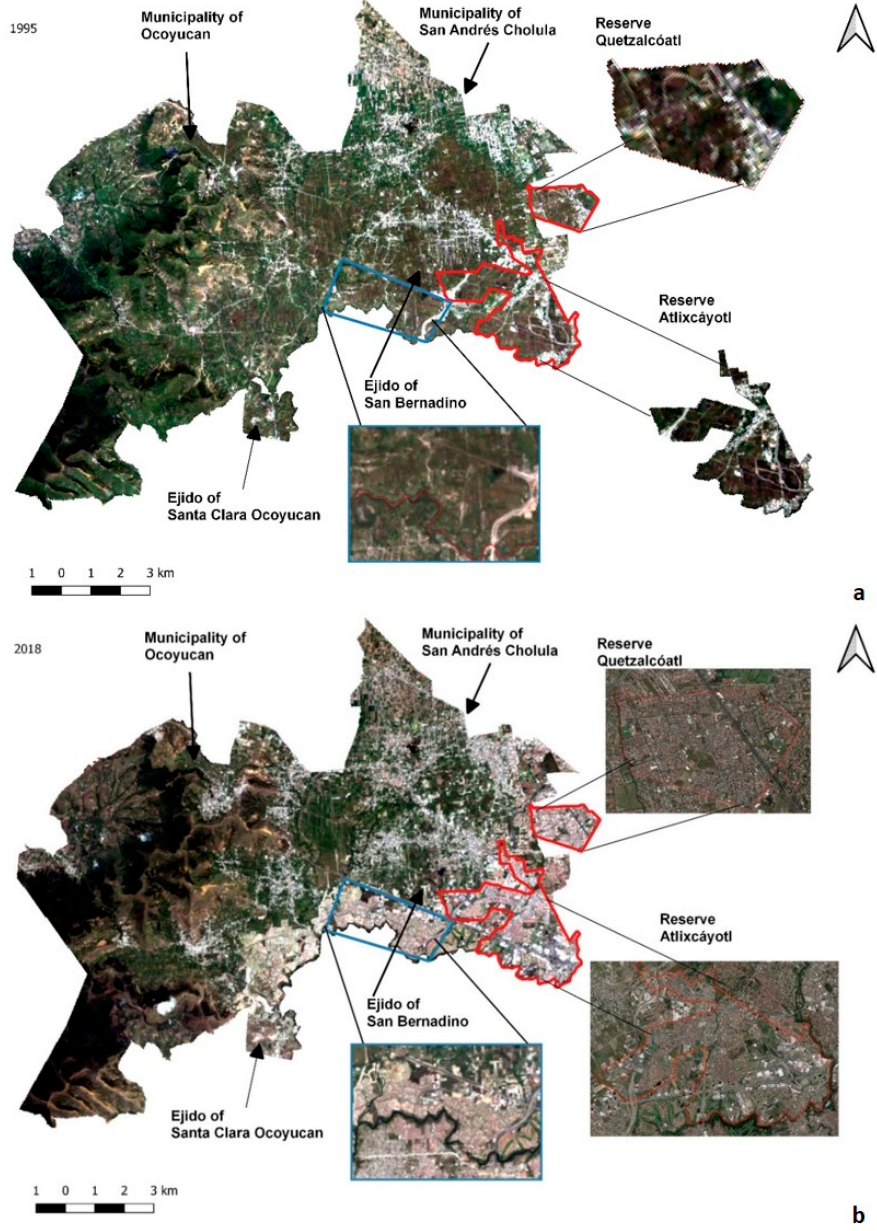
Figure 4. Spatial development in ( a ) 1995 and ( b ) 2018.